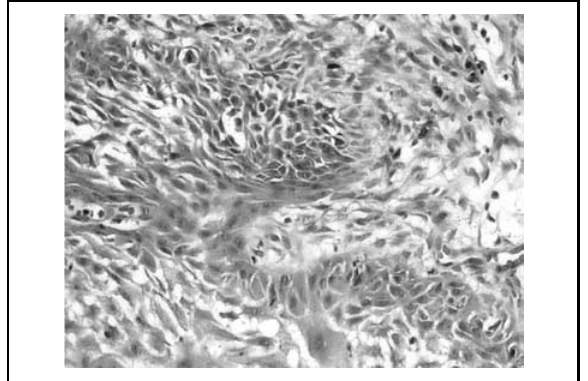
Figure 3 – Neoplasic cells high-power photomicrograph (H&E) resembles the stellate reticulum of an ameloblastoma (x